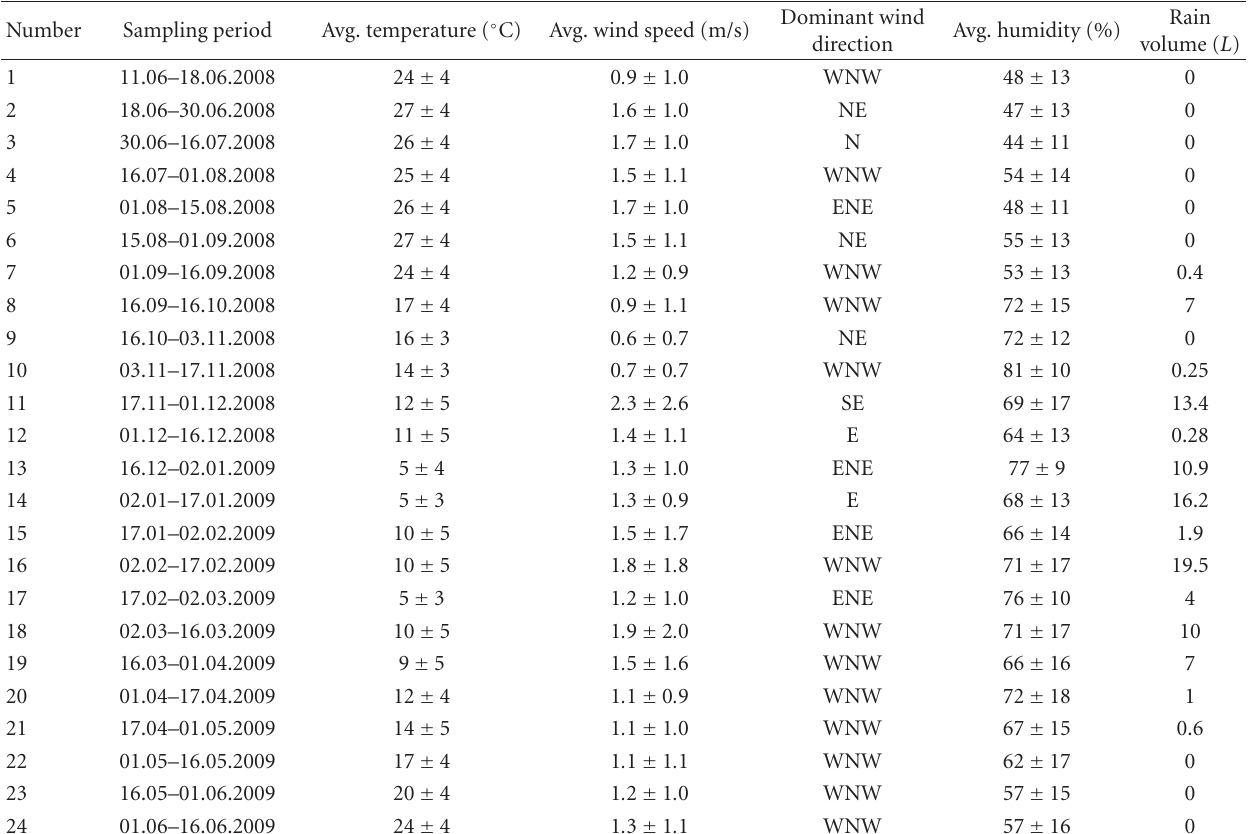
Table 1: Measured meteorological data during the sampling